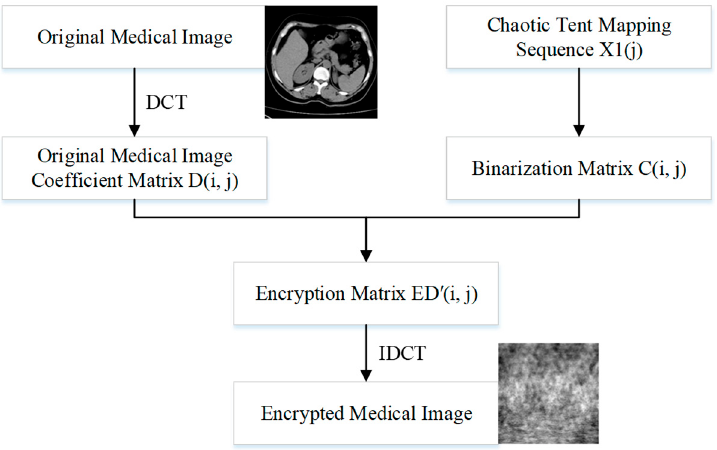
Figure 4. Image encryption process.